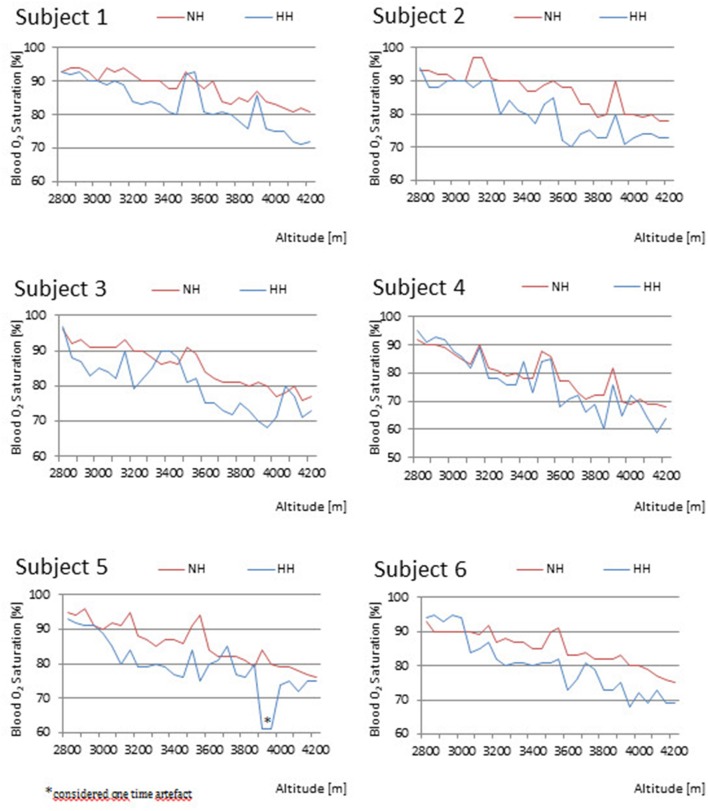
Comparison of individual's peripheral oxygen saturation (SpO2) between normobaric hypoxia (NH) and hypobaric hypoxia (HH).